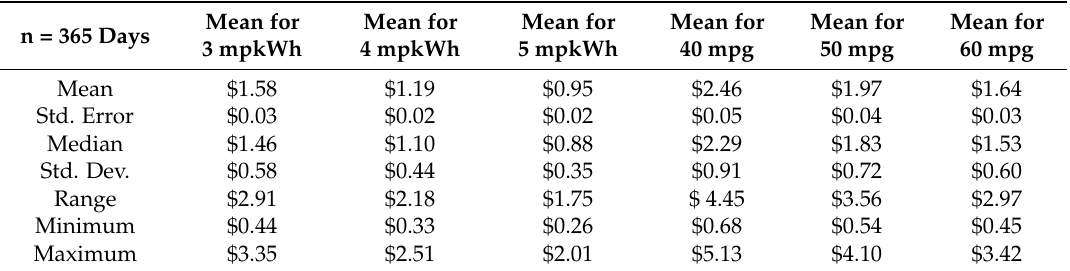
Table 4. Results of the